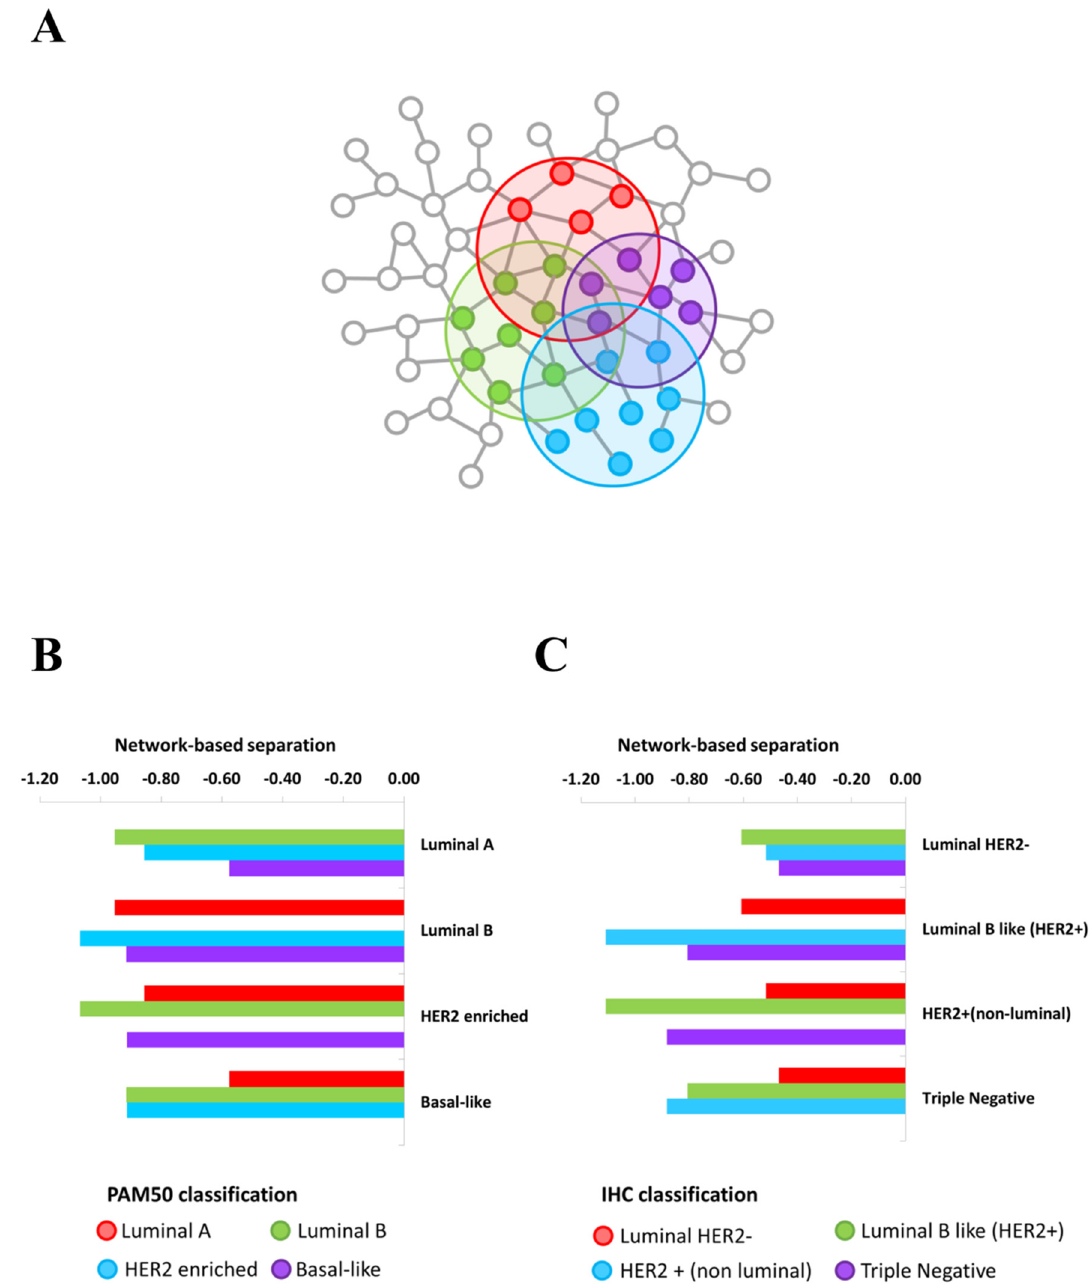
Figure 3. Overlapping BC subtype PPI-based modules by switch genes. ( A ) Schematic representation of the overlapping modules identified by BC subtypes switch genes in the human interactome. ( B , C ) Bar plot reporting the values of the network-based separation measure computed between each pair of switch genes’ modules of PAM50 classification ( B ) and IHC classification ( C ).